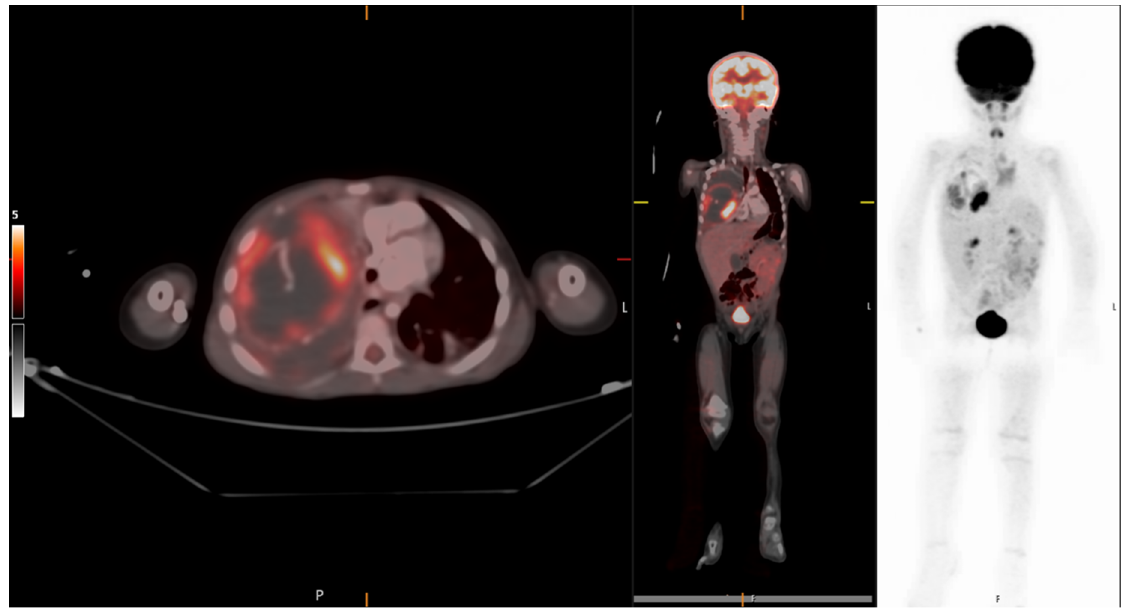
Figure 5. The same patient as in image 4. FDG PET-CT in the axial and coronal hybrid images and coronal PET image show peripheral uptake in the lung lesion. No metastases seen.